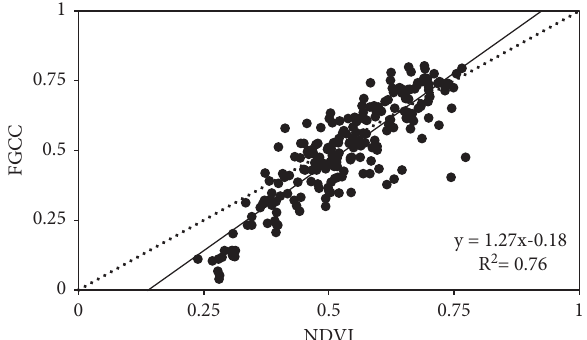
Figure 2: Regression relationship between fractional green canopy cover (FGCC) values and NDVI (normalized difference vegetative index) for 13 sites in Oklahoma in the 2019-2020 growing season.